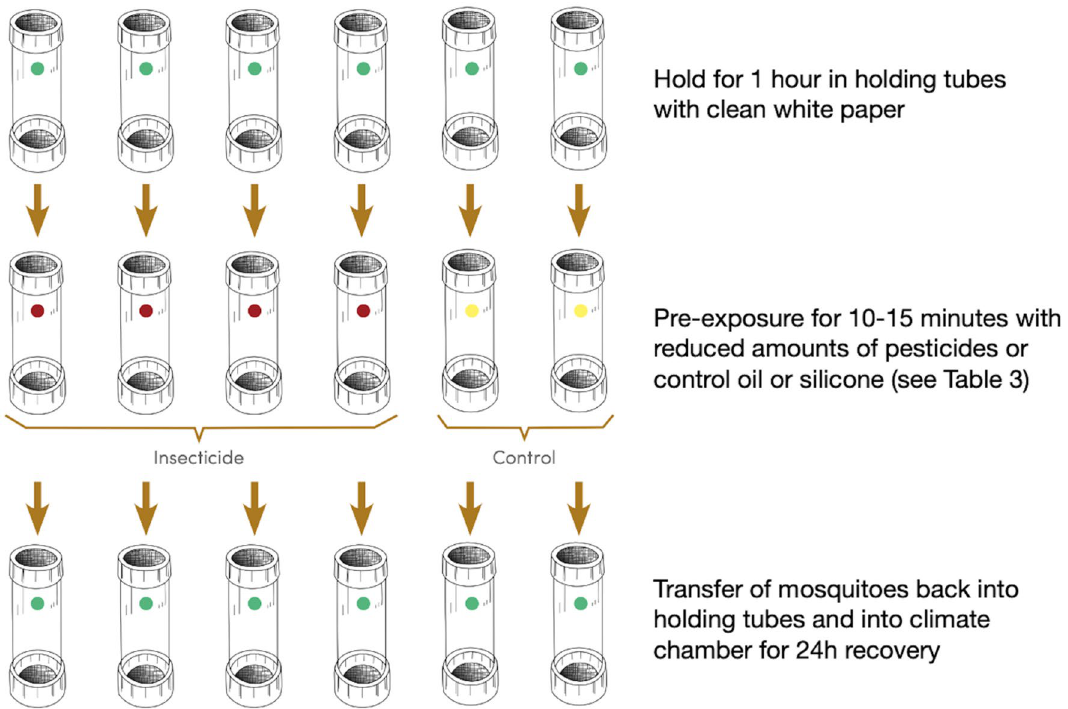
Figure 5. Mosquito conditioning using WHO’s pesticide bioassay tube test system (figure adapted from (WHO 2016)). The assay was modified so as to subject the majority of mosquitoes to a sub-lethal dose of pesticide to induce conditioning through association of the pesticide smell with toxic-effects. Pre-exposed conditioned female mosquitoes were then subjected to 2 assays of associative memory (see Methods and Fig. 6a,